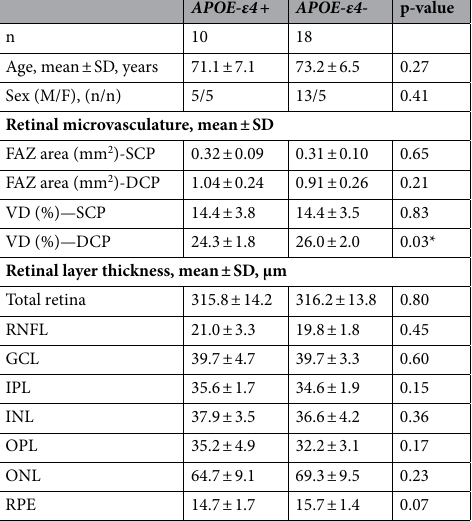
Table 5. Optical coherence tomography and optical coherence tomography angiography parameters of APOE-ε4 carriers and non-carriers. APOE = apolipoprotein E, M = male, F = female, FAZ = foveal avascular zone, SCP = superficial capillary plexus, DCP = deep capillary plexus, VD = vessel density, RNFL = retinal nerve fiber layer, GCL = ganglion cell layer, IPL = inner plexiform layer, INL = inner nuclear layer, OPL = outer plexiform layer, ONL = outer nuclear layer, RPE = retinal pigment epithelium, SD = standard deviation. *p <